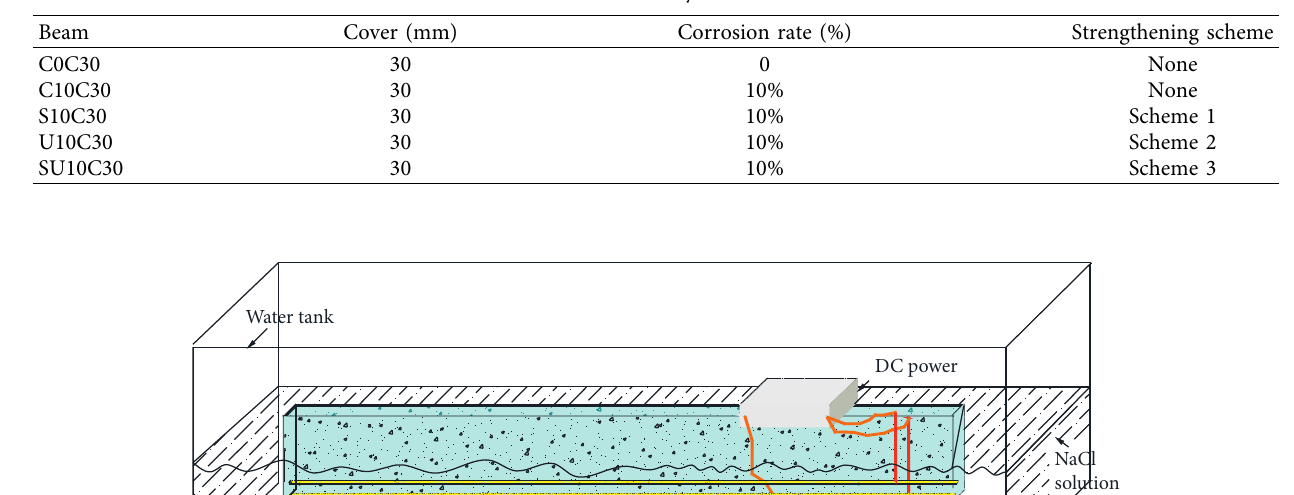
Figure 1: Steel bars details of the beam (unit: mm). Table 1: Summary of beams.